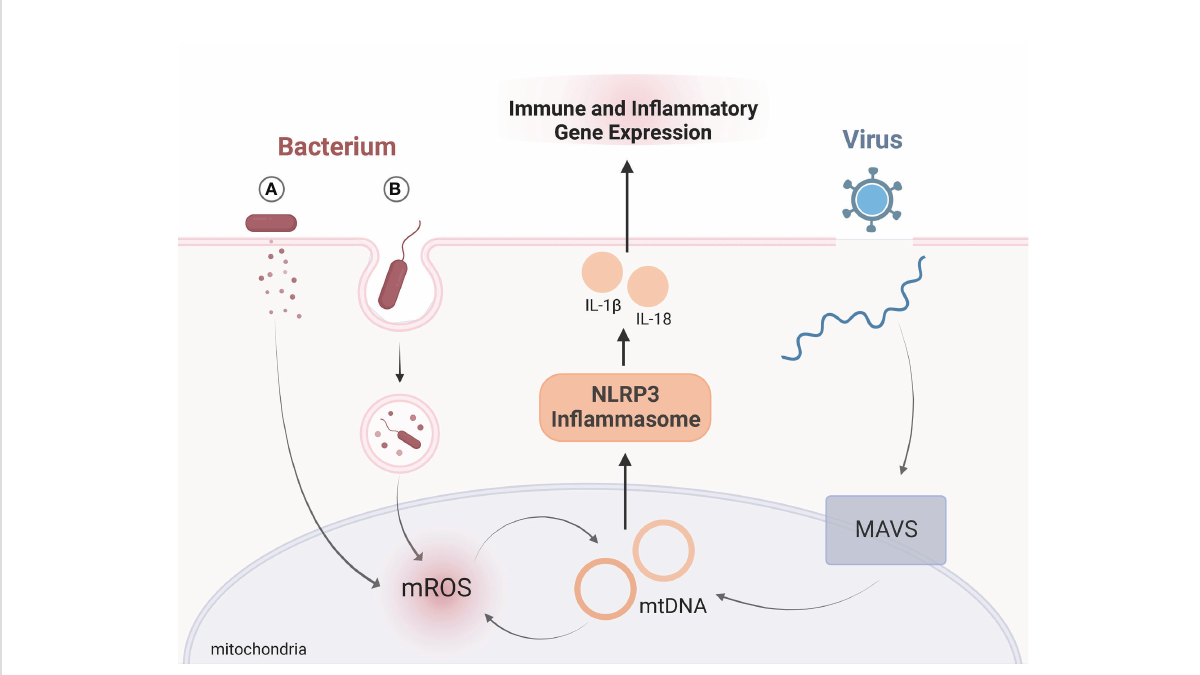
FIGURE 1 Viral and Bacterial Targeting of MitochondriaSchematic representation of role of mitochondria in immune signaling upon viral (blue) or bacterial (red) infection. Exposure to viruses or bacteria both activate immune responses by altering mitochondrial dynamics, namely the NLRP3 in fl ammasome (orange). Upon viral infection, mitochondrial antiviral-signaling protein (MAVS) is located in the outer mitochondrial membrane and serves as an important signaling. MAVS triggers release of mtDNA which activates the NLRP3 in fl ammasome. Bacteria manipulate mitochondria during infection by either (A) secreting bacterial proteins or toxins, or (B) entering host cells via phagocytosis where mitochondria are recruited to the phagosome through toll-like receptor (TLR) signaling. Bacteria can either suppress or amplify mROS generation. The antimicrobial activity of mROS in fl uences mtDNA “ leakage ” , which further ampli fi es mROS, and activation of the NLRP3 in fl ammasome. For both viral and bacterial infections, activation of the NLRP3 in fl ammasome triggers the release of IL-1 b and IL-18. Release of these proin fl ammatory cytokines in fl uences immune and in fl ammatory gene expression. Adapted from “ Endocytosis and Exocytosis with Membrane Rupture (Layout) ” , by BioRender.com. Retrieved from